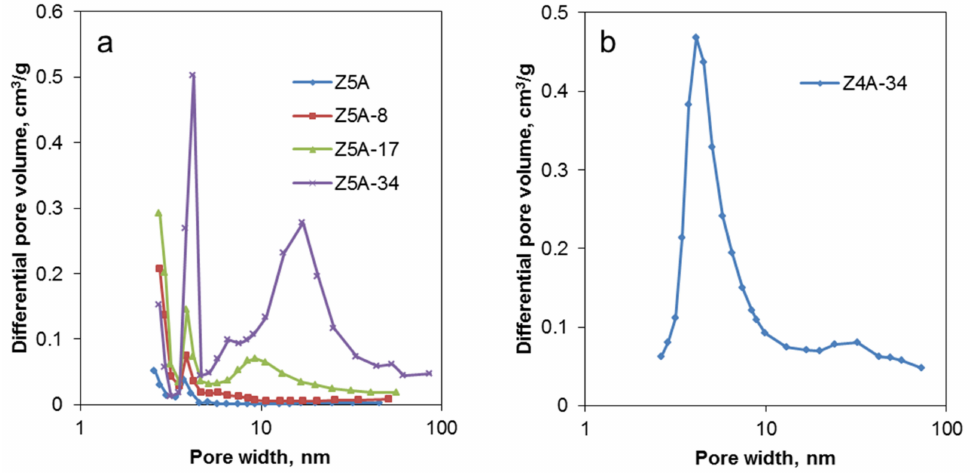
Figure 5. Pore size distribution of parent and EDTA dealuminated zeolite 5A ( a ) and Z4A-34 sample ( b ). For Z4A, Z4A-8 and Z4A-17, no evaluable measurements could be obtained, in